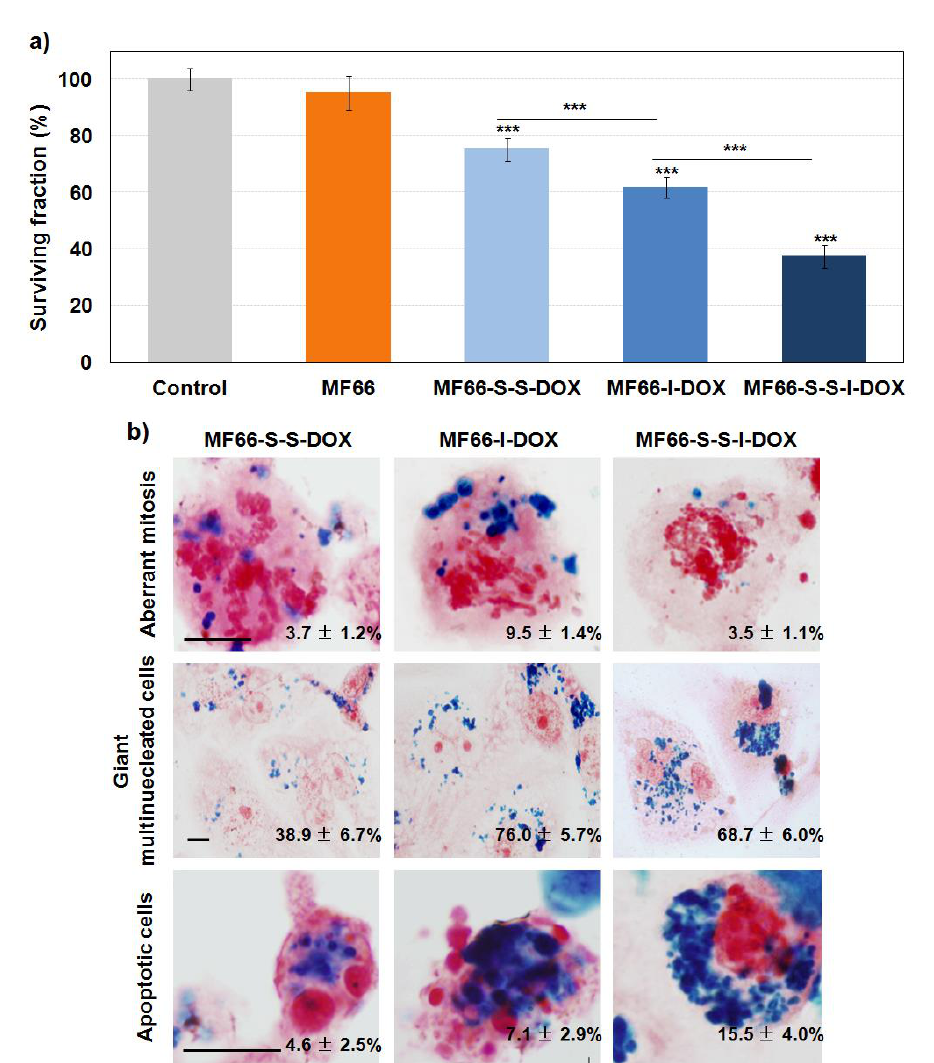
Figure 5. E ff ect of the di ff erent covalent formulations 72 h after the incubation for 24 h in MDA-MB-231 cells. ( a ) Cellular viability assessed by AlamarBlue ® . ( b ) E ffi cient uptake and morphological e ff ects analysed by Prussian blue staining. Scale bar: 10 µ m. Percentages included are the mitosis, number of giant multinucleated cells or apoptosis over the total number of